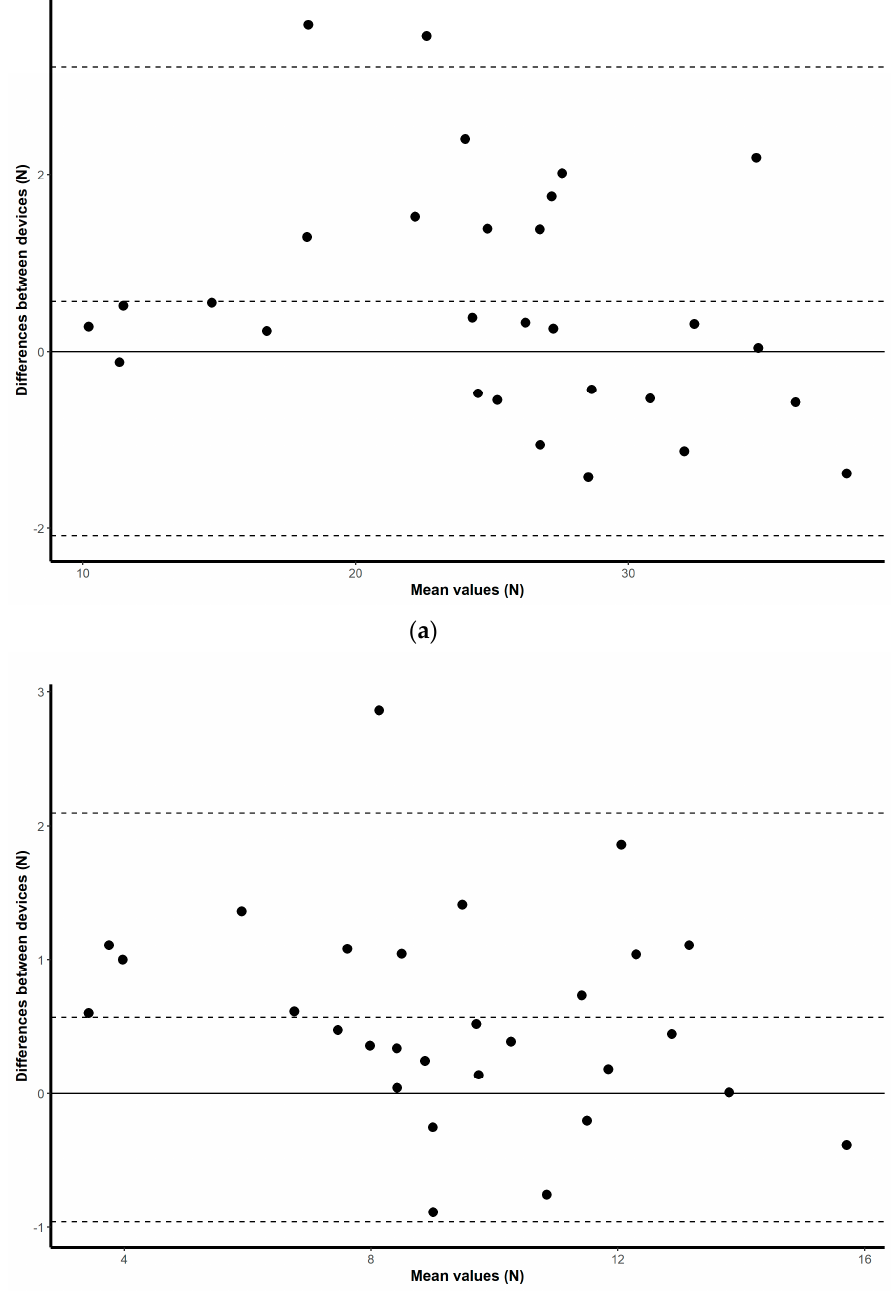
Figure 7. Session two mean difference plot comparison of the results from the HX711 microcontroller- based load cell and the handheld dynamometer for: ( a ) maximal isometric leg extension; ( b ) maximal isometric bicep flexion. The middle-dashed line represents the mean difference and the upper and lower dashed lines represent the 95% limits of agreement (mean ± 1.96 * SD).